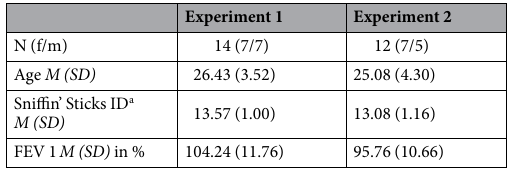
Table 1. Demographic data of subjects who were included in the final analysis of experiment 1 and 2. Note . The samples did not differ statistically in any of the listed criteria ( p > 0.05). a ID: Identification